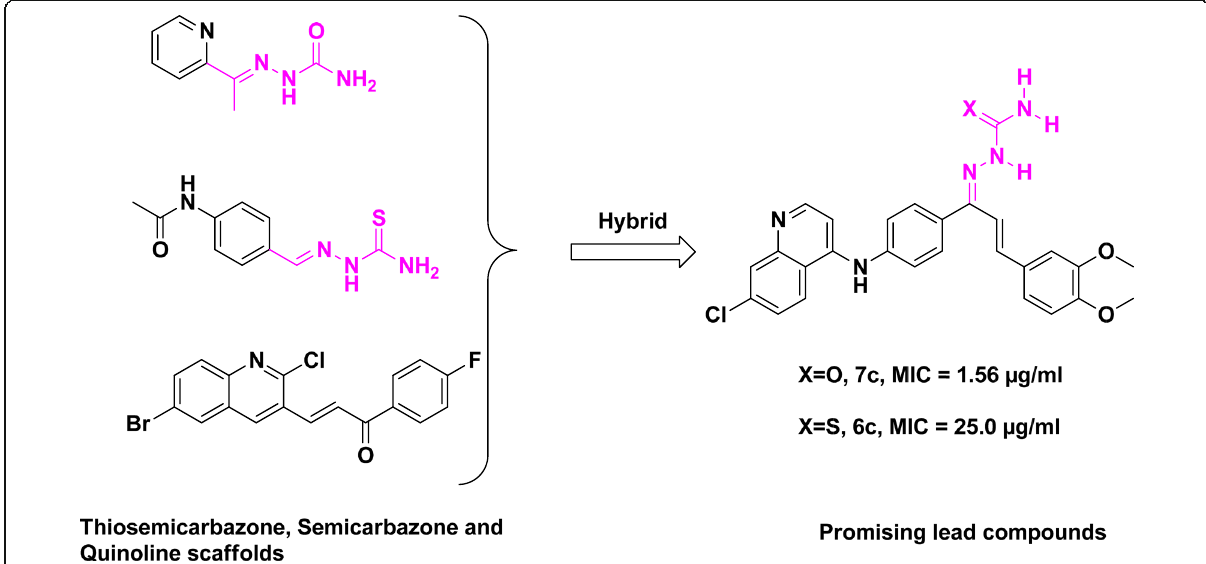
Fig. 1 Design strategy for the quinoline analogs containing thiosemicarbazone/semicarbazone